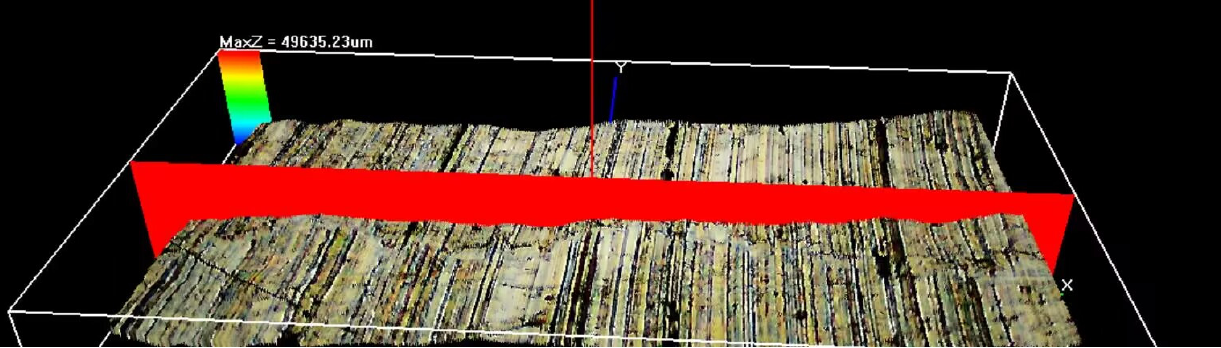
Figure 21. Comparison of w orkpiece cross section profile curve between DACT and BEM. Through numerical analysis, the variance, the standard deviation, and the range of the cross-section profile curve data of the inclined plane machined by the DACT is 29.8403, 5.4626, and 22.3438, respectively. Meanwhile, the variance, the standard deviation, and the range of the cross-section profile curve data of the inclined plane machined by the BEM is 47.1185, 6.8643, and 30.2734, respectively. It is obvious that the variance, the standard deviation, and the range of the cross- section profile curve data of the inclined plane machined by DACT are always smaller than by BEM; thus, better processing quality can be obtained when machining with the DACT. The cutting force component F x , F y , and F z in the direction of the X-axis, Y-axis, and Z-axis, respectively, of the DACT and BEM are shown in Figure 22, while the radial force F rad and the resultant force F res of the DACT and BEM are shown in Figure 23.